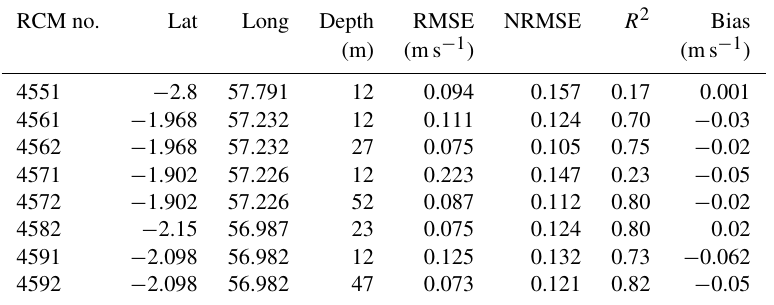
Table 3. Results from the validation of the currents, showing the difference between the modelled and observed current speeds at the eight locations reported in Table 1. RCM no.